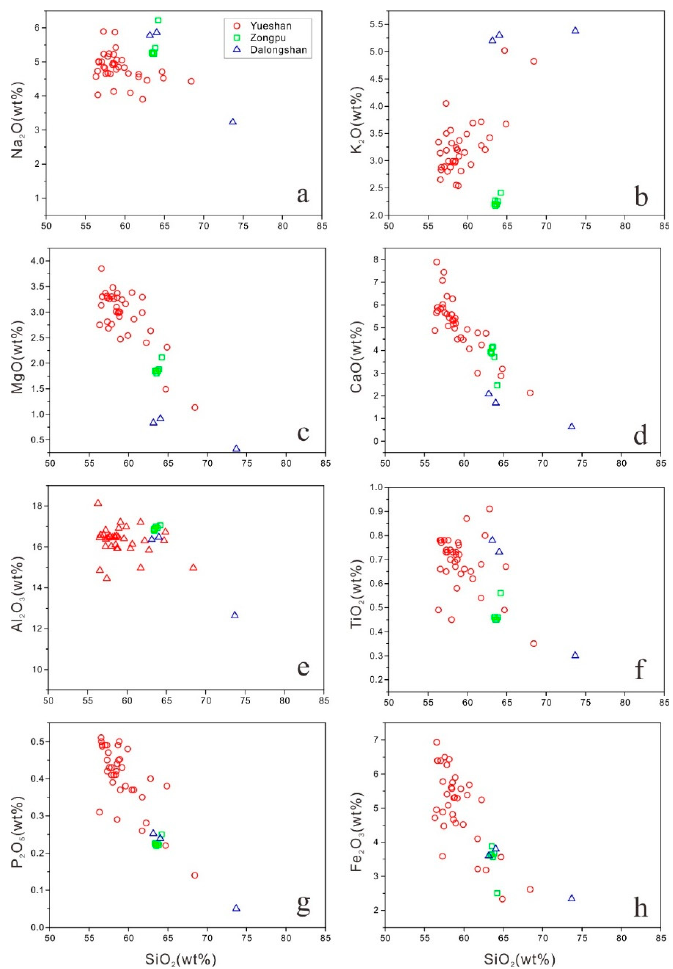
Figure 5. Major element Harker diagrams for diorites and granites in the Anqing orefield. ( a ) NaO 2